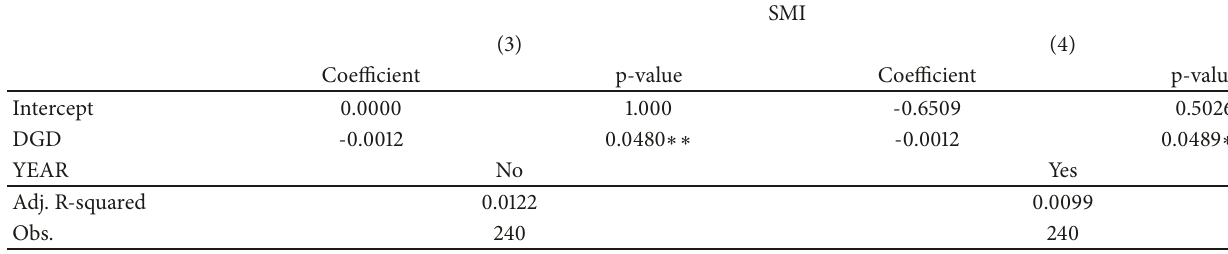
Table 6: Regression Results for Equ. (3) and (4).